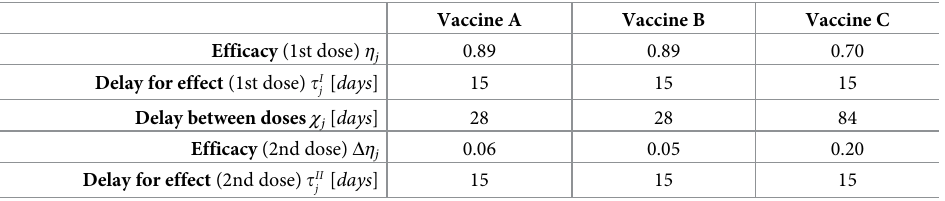
Table 2. Efficacy of the vaccines considered in the proposed case study. Vaccine A mimics BNT162b2 (Pfizer & BioNTech); vaccine B mRNA-1273 (Moderna) and vaccine C ChAdOx1 nCoV-2019 (University of Oxford/AstraZe- neca). The source for the estimates are: